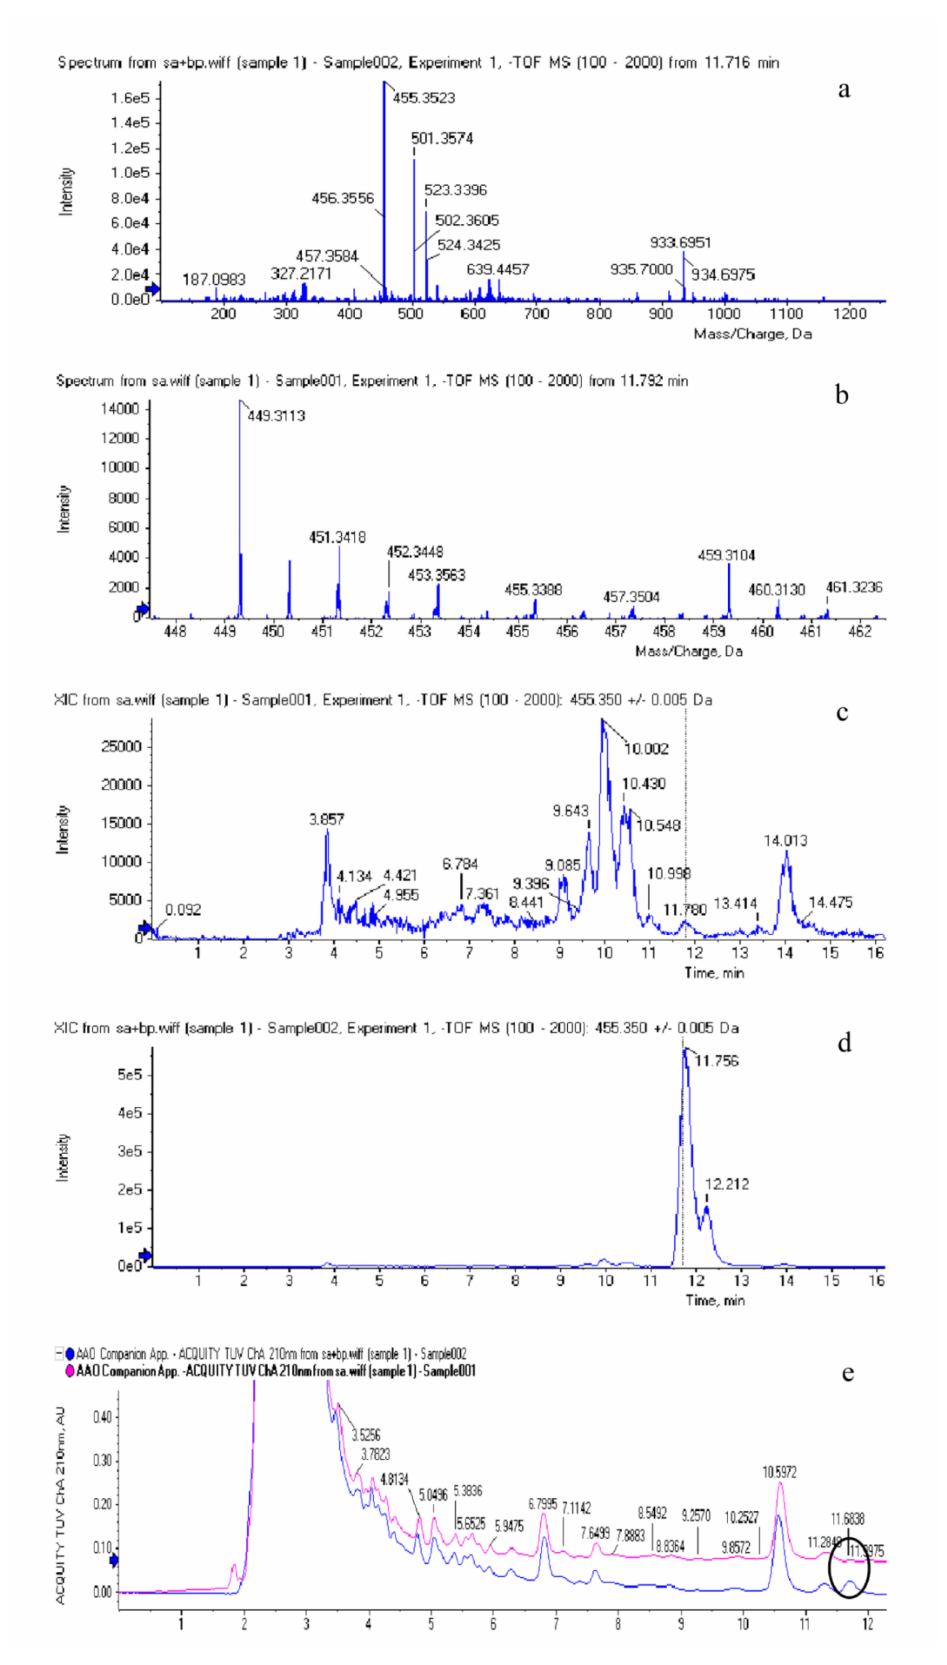
Figure 2. Deprotonated molecular ions in the mass spectra for BA in ( a ) internal standard (IS) and ( b ) sample, Chro- matograms of BA in sample ( c ) and IS ( d ). Peaks of BA in sample and IS in the same chromatogram ( e